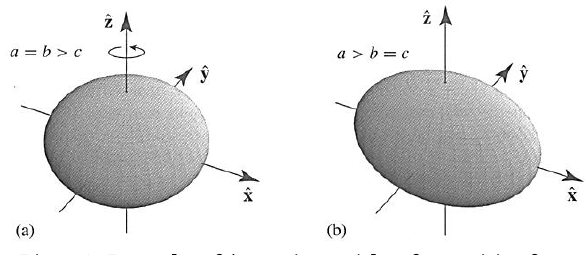
Figure 3: Examples of the equipotential surfaces arising from (a) rotational deformation, where the rotational axis is aligned with the z axis, and (b) tidal deformation, where the tide-raising body lies along the direction of the x axis (Figure adopted from Murray and Dermott, 1999).